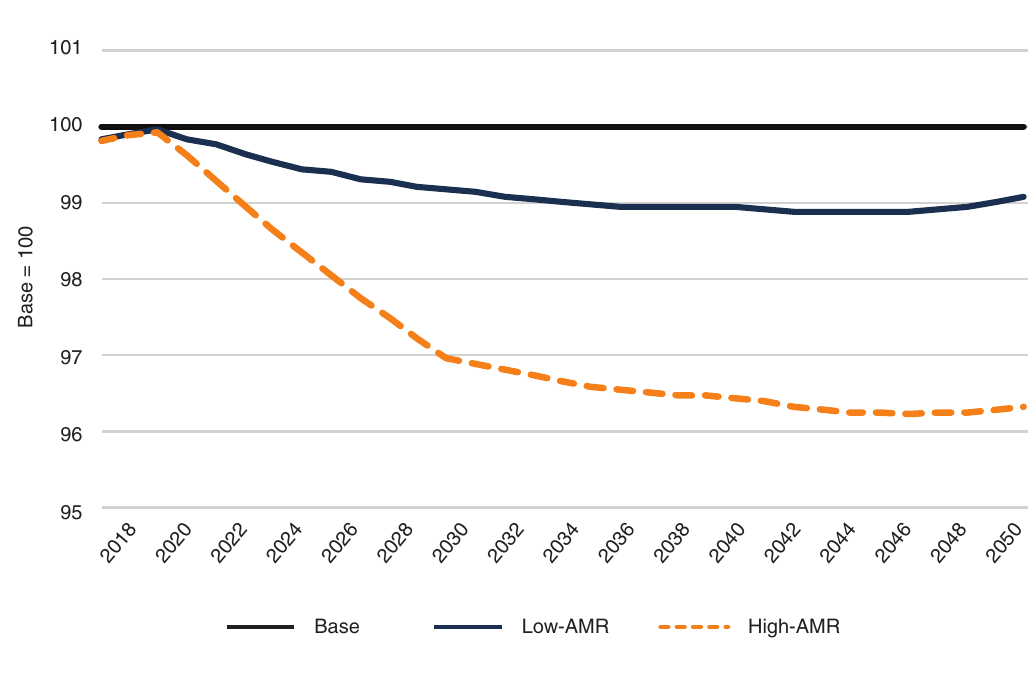
FIGURE 4. AMR Impact on World